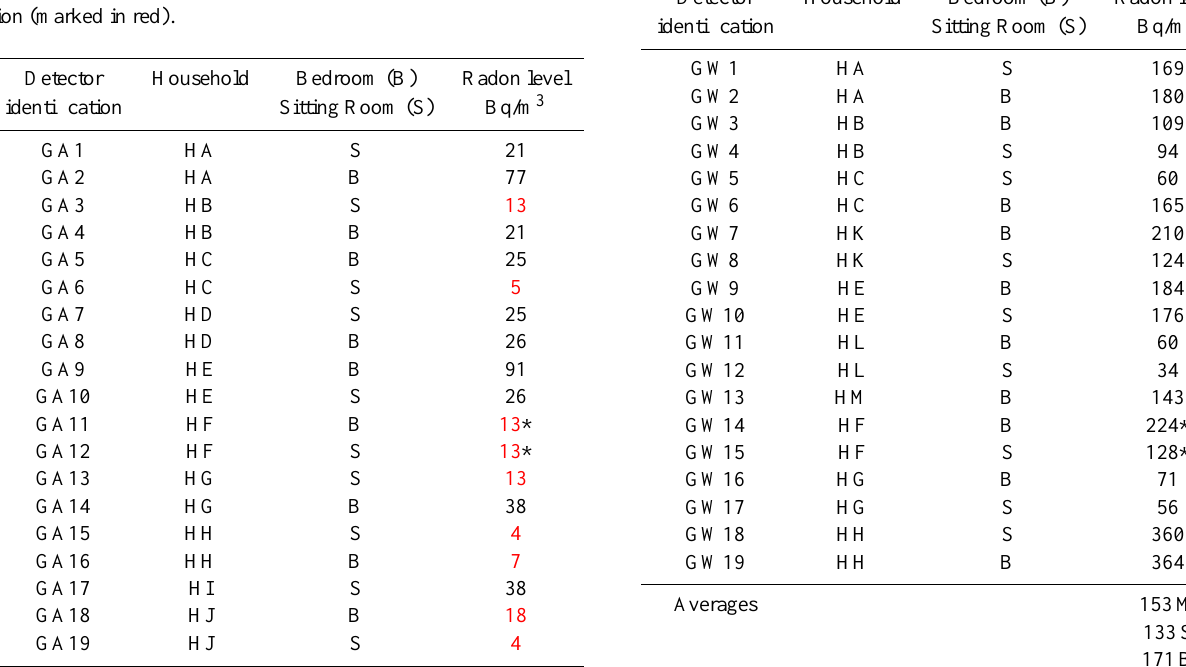
Table 1. Radon levels in Hamadan houses during the autumn sea- son, exposure period of 90 days. The bottom line shows averages for sitting rooms (S), bedrooms (B) and the overall average (M). Households and detector numbers have been coded to protect the identity of individuals. Double glazed property marked with a *. Note that some results are probably below the lower limit of detec- tion (marked in red).